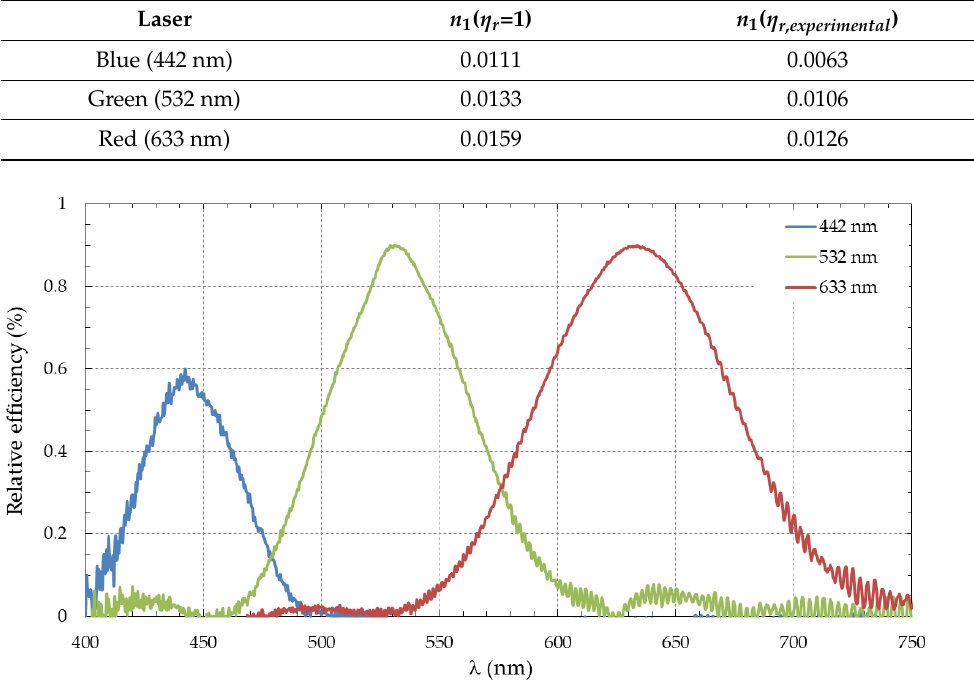
Figure 7. Experimentally measured chromatic selectivity curves for the three maximum efficiency samples obtained in the monochromatic calibration of each of the wavelengths (50 ◦ between beams).